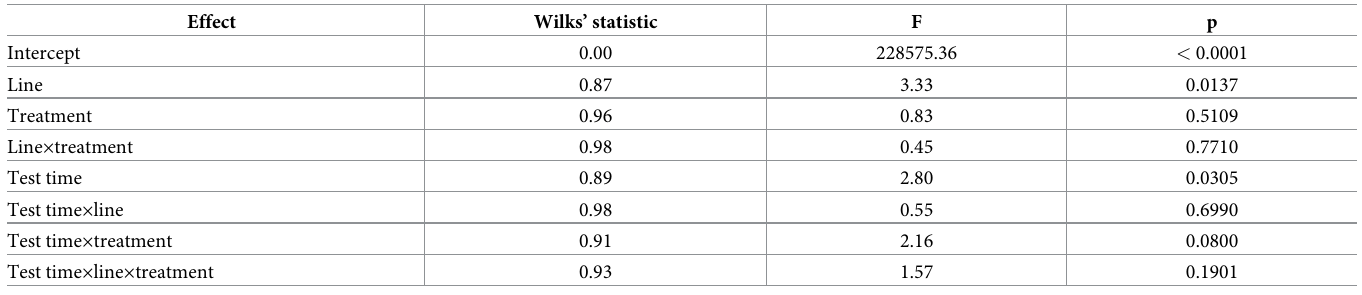
Table 1. The multivariate analysis of variance results for individual factors affecting surface temperature.